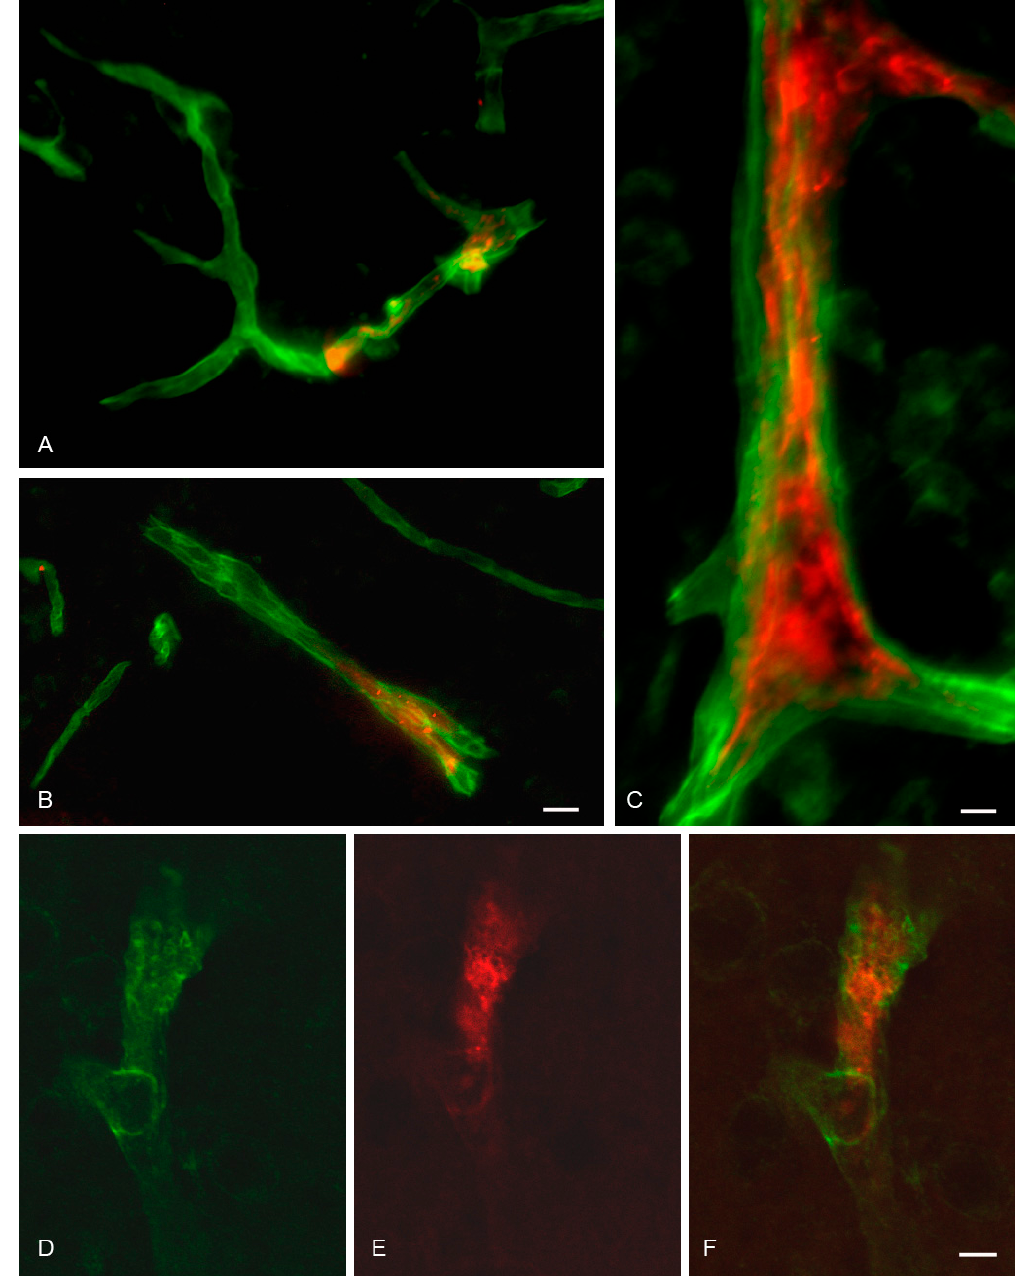
Figure 4. Brain distribution of magnetic OX26 immunoliposomes following in situ perfusion without application of external magnetic force. Images are from rats which received 10 µg/g bodyweight of magnetic OX26 immunoliposomes. ( A – C ) Magnetic OX26 immunoliposomes (red) present inside brain capillaries do not distribute past laminin (green) which marks the basal membrane of brain capillaries. ( D – F ) Co-detection of laminin (green) and magnetic OX26 immunoliposomes (red) using confocal imaging. The pictures show a Z-stack generated from serial analyses of a single brain capillary. ( F ) Merging the two fluorophores reveals that magnetic OX26 immunoliposomes are confined to the interior of the brain capillary. Scale bars = 20 µm ( A , B ), 10 µm (C), and 5 µm ( D – F ).